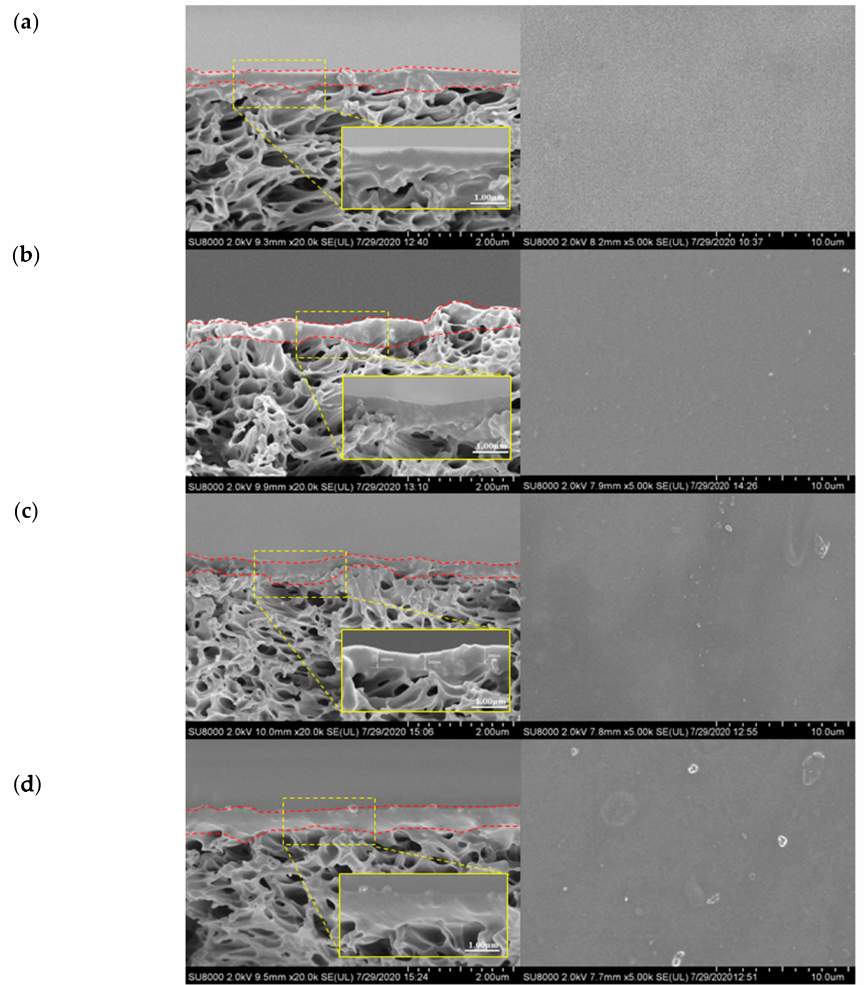
Figure 5. FESEM images of cross-section (left, inset: enlarged image of the coating layer) and surface (right) of the membranes with di ff erent GO loadings: ( a ) 0.0 wt%, ( b ) 0.4 wt%, ( c ) 0.8 wt%, and ( d ) 1.0 wt%